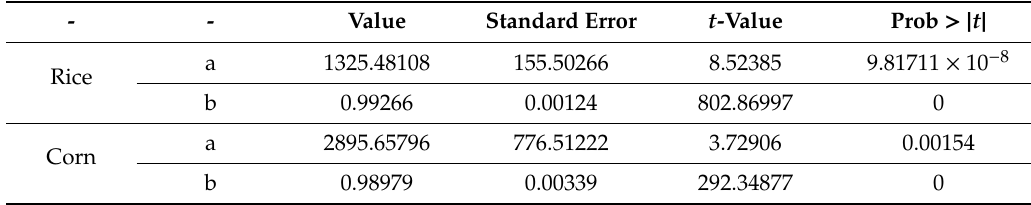
Table 10. Results of significance tests for the coe ffi cients of the integrated energy consumption regression model.